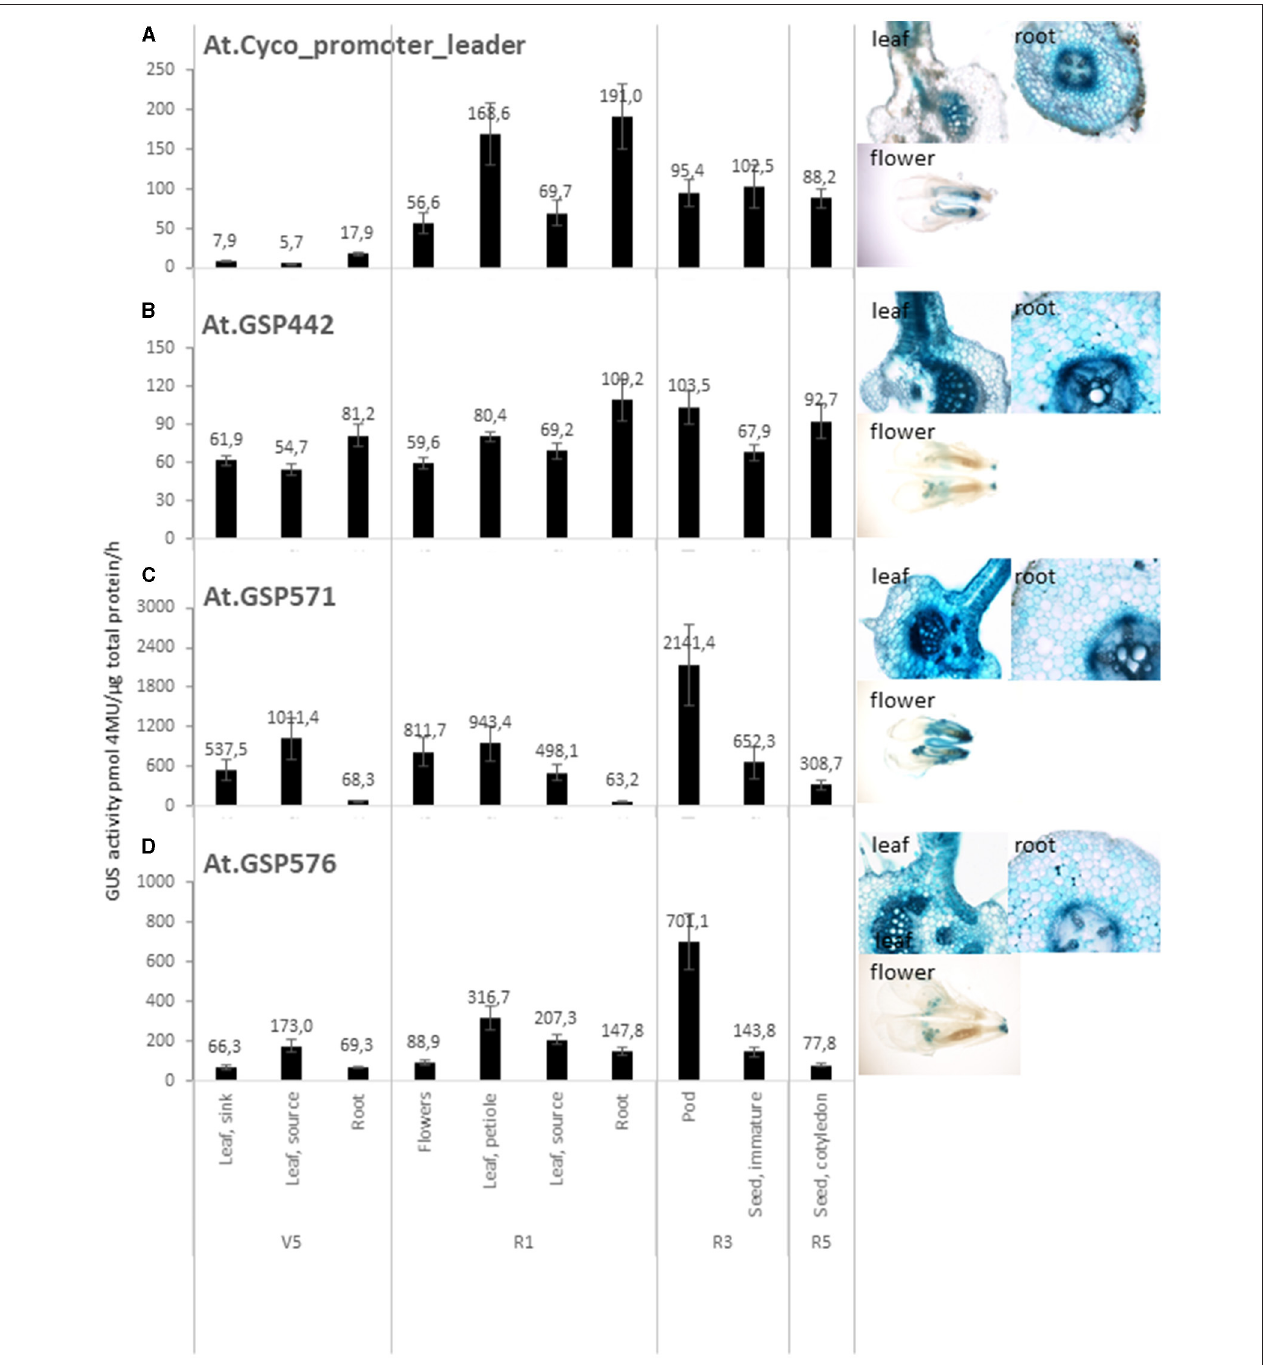
FIGURE 2 | GSPs drive effective gene expression. Quantitative and qualitative analysis of GUS reporter genes driven by promoter and leaders from At.Cyco (A) , At.GSP442 (B) , At.GSP571 (C) , and At.GSP576 (D) . Left panels: Quantitative analysis of GUS reporter gene activity was performed on transgenic soybean plants across multiple tissues, including leaf, root, flowers, pods, and seeds over vegetative (V5) and reproductive (R1, R3, and R5) stages. GUS enzyme activity on MUG substrate was normalized to total protein and reported as pmol 4-MU/ µ g total protein/h. At least six independent transgenic events were analyzed, and the data are reported as the mean with standard error. Right images: Qualitative analysis was performed on leaf, root, and flowers at the R1 stage. Tissue cross - sections (leaf and root) or whole mount (flower) were incubated with X-Gluc substrate to produce blue staining where GUS enzyme activity was detected. At least five independent transformation events were imaged, and one representative image is